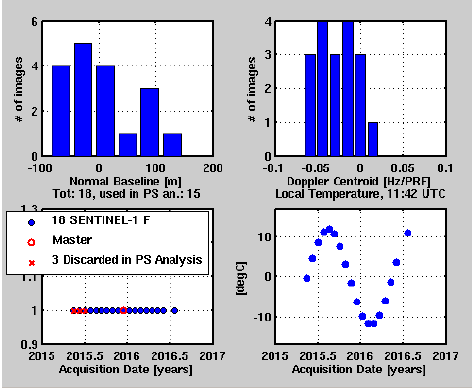
Figure 1 Statistical information of the data